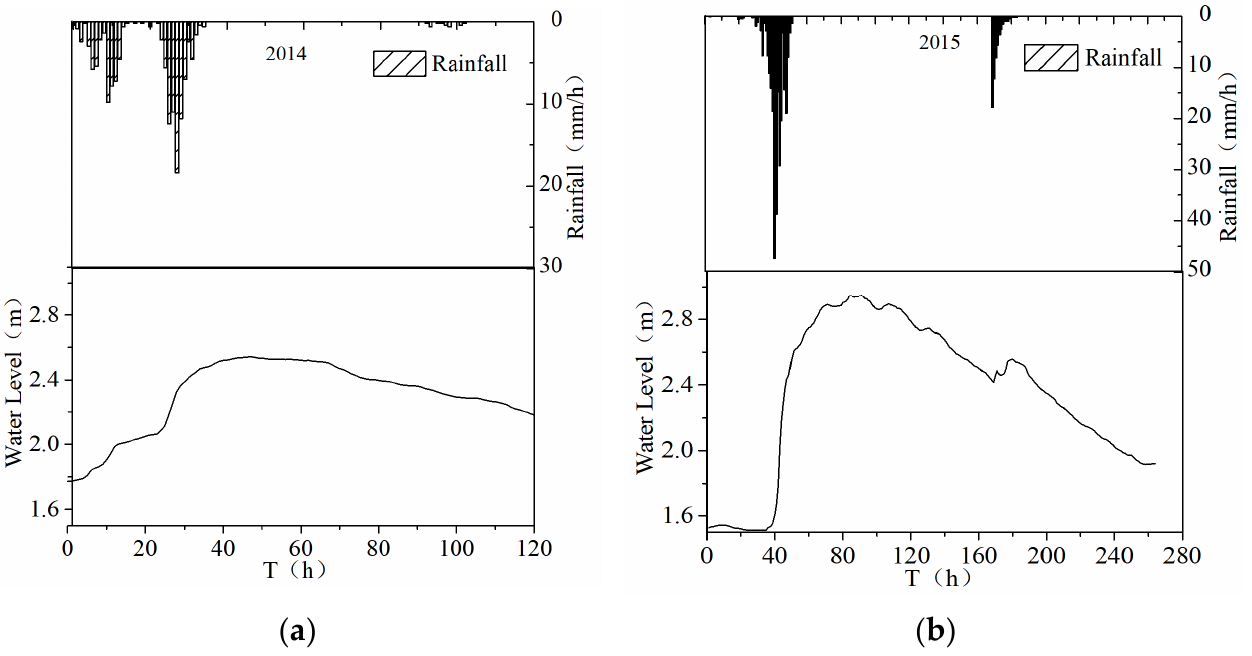
Figure 6. Rainfall process distribution. ( a ) Rainfall Event 1; ( b ) Rainfall Event 2.